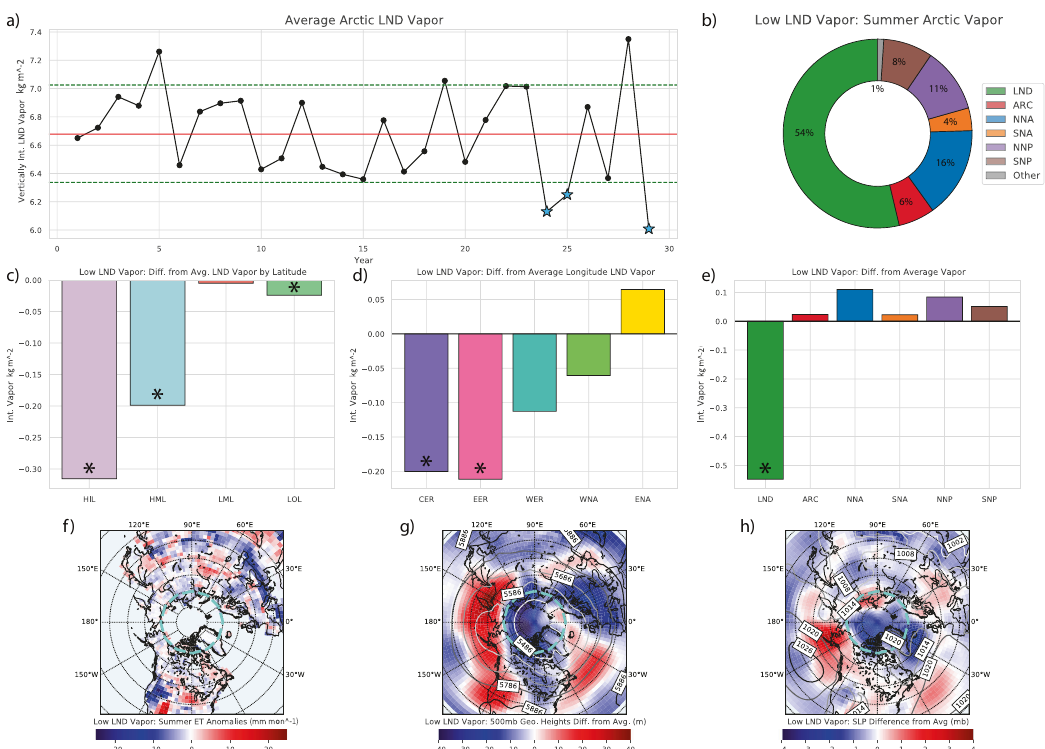
Fig. 10 Conditions associated with the largest negative anomalies of land vapor in the Arctic. a Average summer land vapor in the Arctic for each year of the simulation. The blue stars denote anomalously low land vapor years used in panels b – h . b The percent contribution to total Arctic vapor from land and individual ocean regions in anomalously low land vapor summers. c The anomalies in land vapor contributions from latitude-based regions during low Arctic land vapor summers. d The anomalies in land vapor contributions from longitude-based regions during low Arctic land vapor summers. e The anomalies in vapor contributions from land and individual ocean regions during low Arctic land vapor summers. f The anomalies in ET during low Arctic land vapor summers. g The average 500 mb GPH fi elds (contours) and difference from climatological mean (shading) during low Arctic land vapor summers. h The average SLP fi elds (contours) and difference from climatological mean (shading) during low Arctic land vapor summers. Asterisks on the bars in c – e indicate statistically signi fi cant anomalies (see